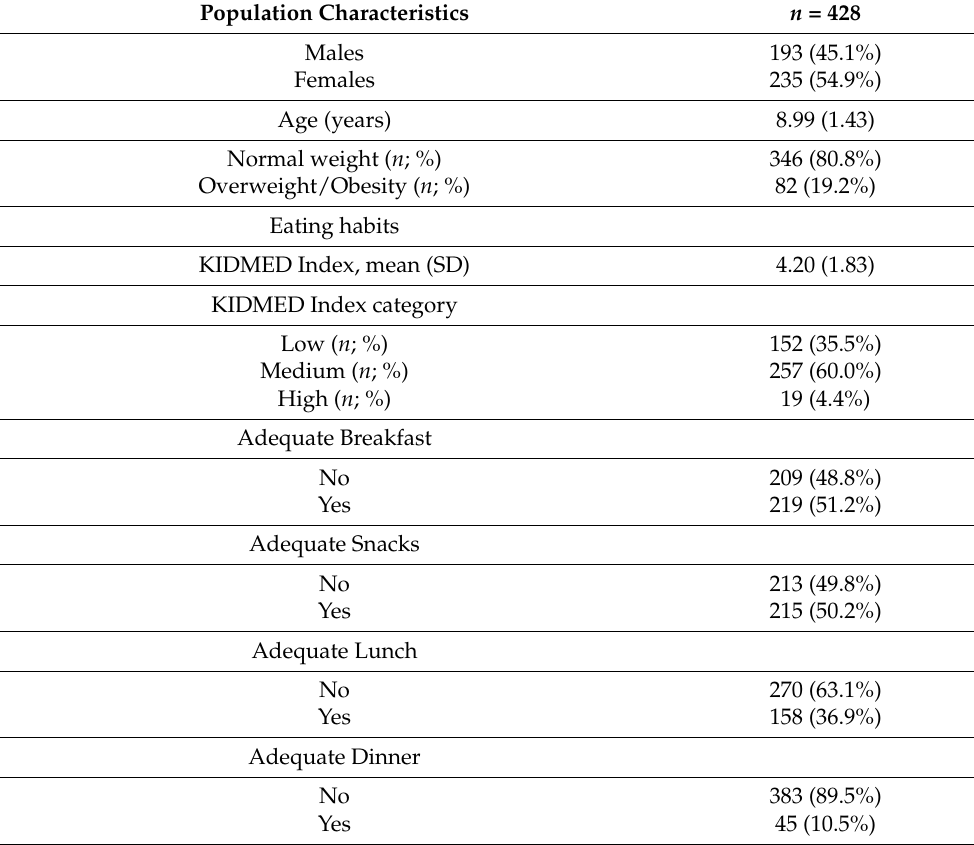
Table 1. Population characteristics and weekly